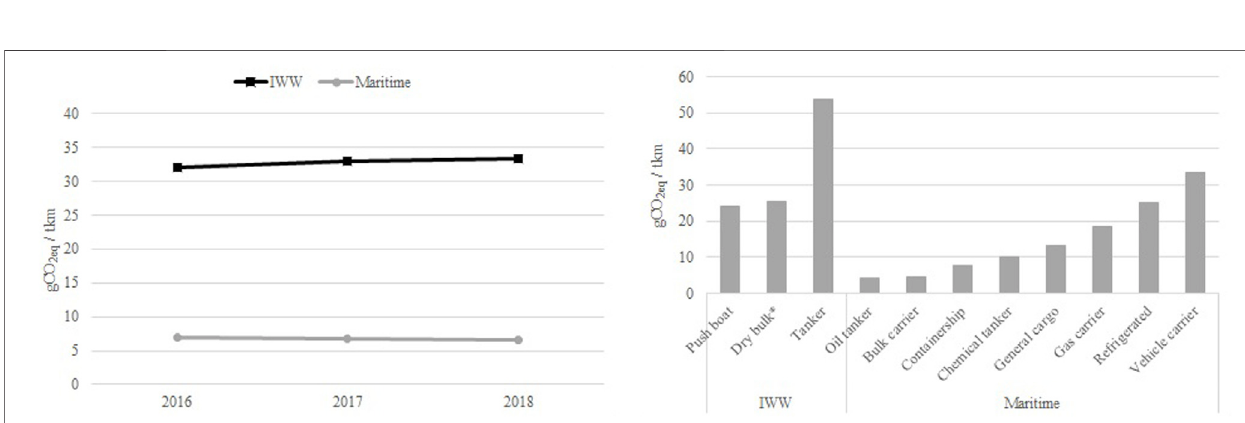
Frontiers in Energy Research |